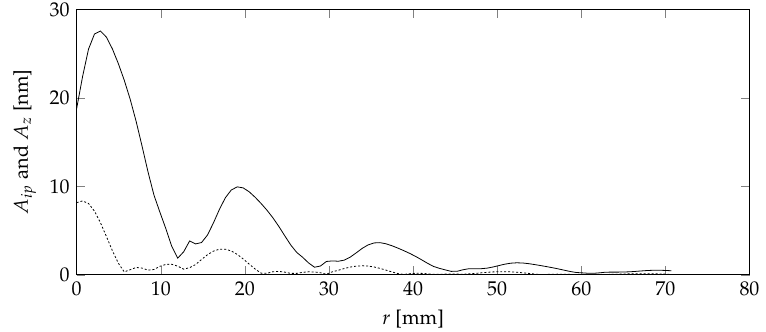
Figure 12. Calculated in-plane amplitude (dashed) and out-of-plane amplitude (solid).